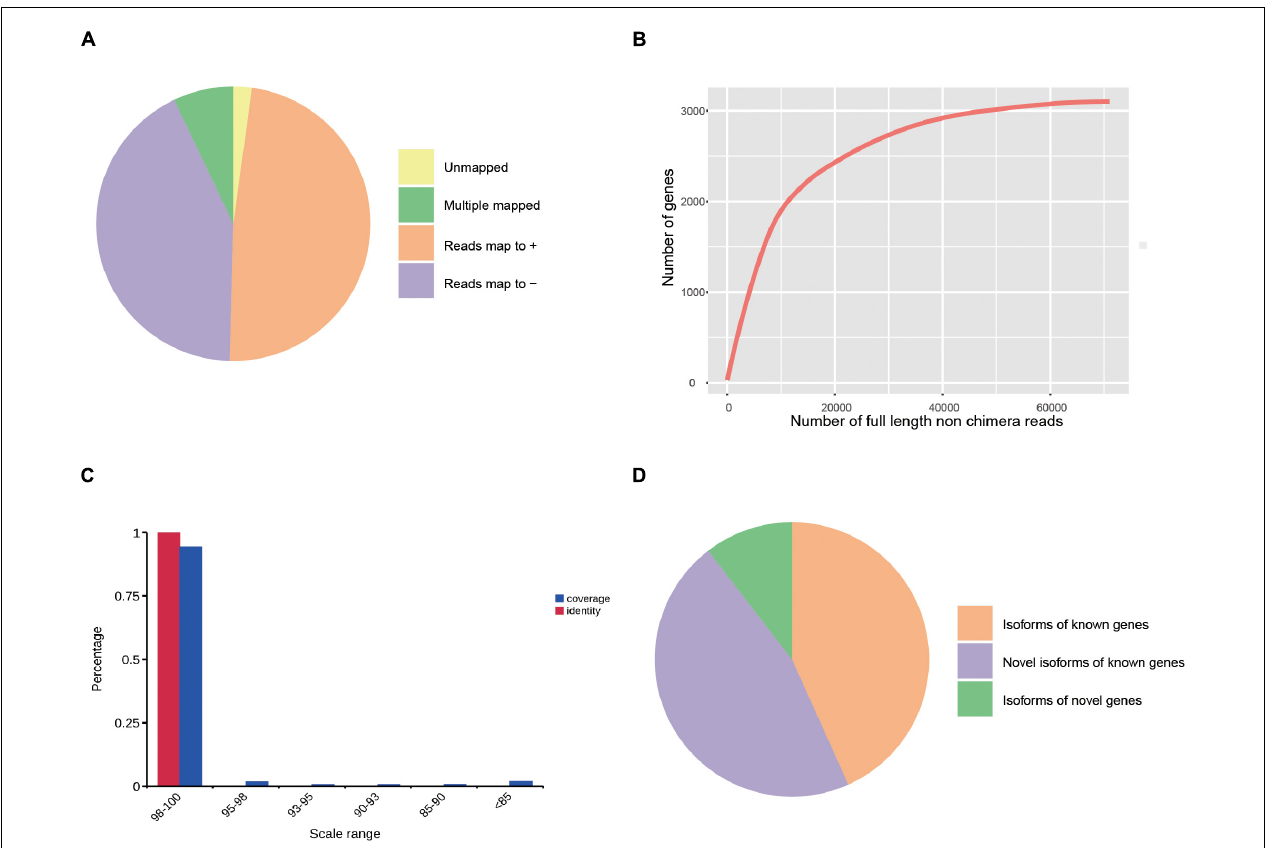
FIGURE 2 | Genome Mapping and Alignment Program (GMAP) analysis of SMRT sequencing. (A) GMAP mapping statistics of the corrected sequences. (B) Saturation curve of corrected sequences, x -axis represents numbers of full-length non-chimera (FLNC) reads, y -axis represents numbers of genes. (C) Range of mapping coverage and identity, x -axis represents the scale ranges, y -axis represents the percentages. (D) Classification of transcript isoforms